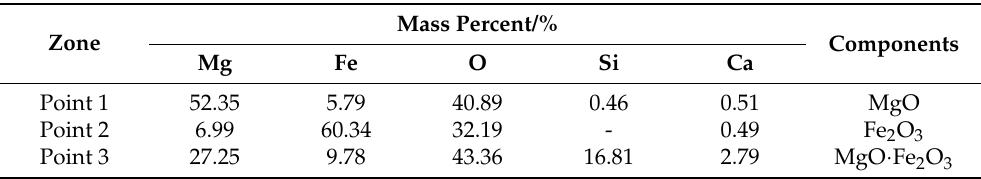
Figure 10. The XRD analysis of Fe 2 O 3 -MgO of samples after reduction. The SEM analysis of Fe 2 O 3 -MgO samples after reduction is shown in Figure 11, and the EDS analysis is shown in Table 6. It can be seen that the sample included unmineral- ized MgO, MgO·Fe 2 O 3 by mineralized and iron oxide (Fe 2 O 3 and Fe 3 O 4 ). It should be noted